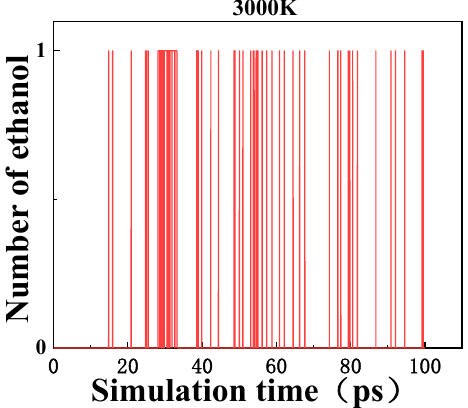
Figure 6. The curve of 20 cellobioses to produce ethanol molecules.